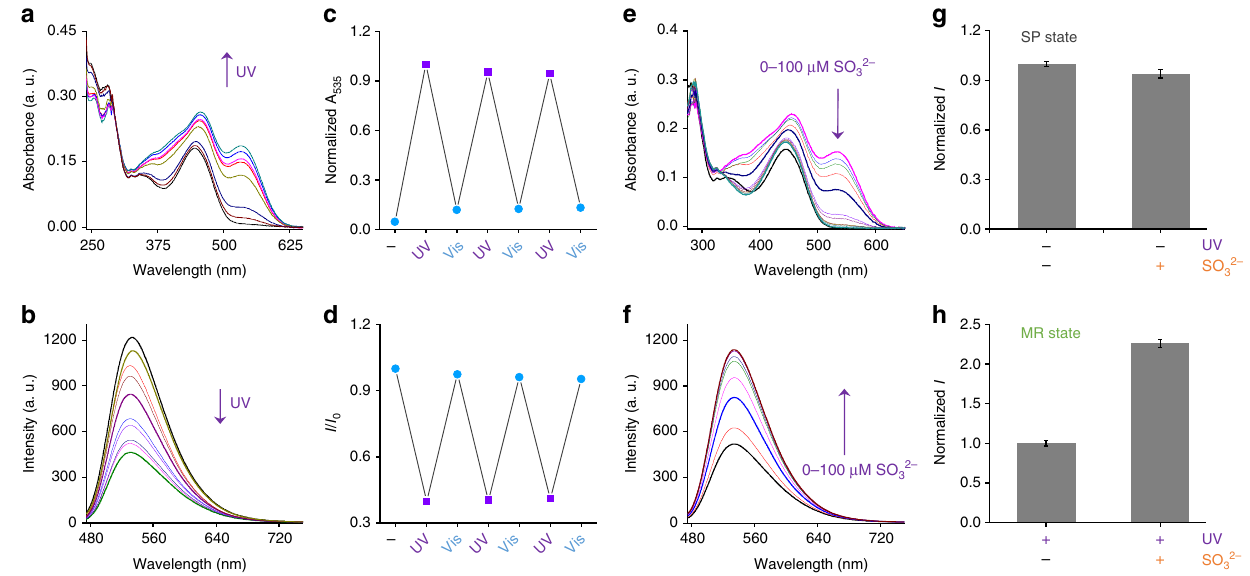
Fig. 2 Spectroscopic analyses of photochromic SP-Gal and the remote light-controlled fl uorescence sensing of sul fi te. a UV – Vis absorbance spectral changes of SP-Gal (10 μ M) in phosphate buffered saline (PBS, 0.01 M, 1% DMSO, pH 7.4) at 298 K upon irradiation at 365 nm (2.6 mW cm − 2 ). b The fl uorescence spectral changes of SP-Gal (10 μ M) in PBS (0.01 M, 1% DMSO, pH 7.4) at 298 K upon irradiation at 365 nm (2.6 mW cm − 2 ). c UV-Vis absorbance photo-switching (at 535 nm) of SP-Gal/MR-Gal (10 − 5 M) in PBS (0.01 M, 1% DMSO, pH 7.4) at 298 K. d Fluorescence emission photo- switching (at 544 nm; excitation wavelength: 450 nm) of SP-Gal/MR-Gal (10 − 5 M) in PBS (0.01 M, 1% DMSO, pH 7.4) at 298 K, where I 0 and I are the initial fl uorescence intensity of SP-Gal and that of the corresponding SP-Gal / MR-Gal upon alternate UV – Vis irradiation, respectively. e The UV-Vis absorbance change of MR-Gal (10 μ M, in PBS buffer) with SO 3 2 − (from 0 to 100 μ M). f The fl uorescence change of MR-Gal (10 μ M, in PBS buffer) with SO 3 2 − (from 0 to 100 μ M). g , Fluorescence intensity ratio of SP-Gal without UV irradiation (365 nm) in the absence and presence of SO 3 2 − (100 μ M). h Fluorescence intensity ratio of MR-Gal (SP-Gal with UV irradiation at 365 nm) in the absence and presence of SO 3 2 − (100 μ M). The error bar